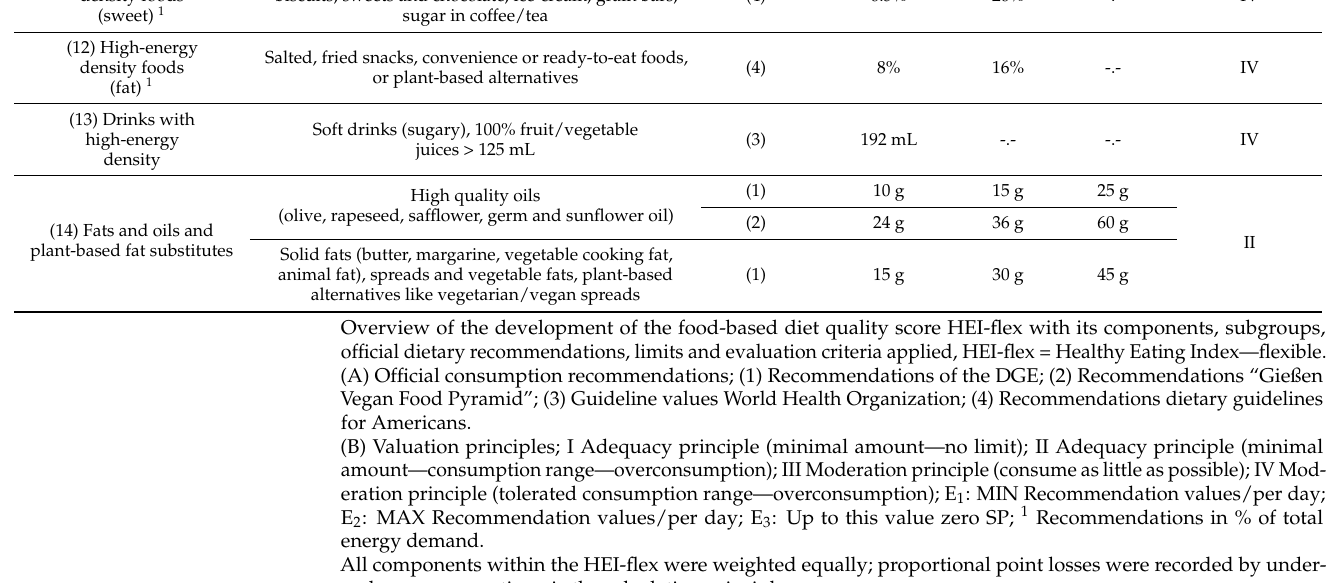
Table 1. HEI-flex components, subgroups and evaluation criteria.